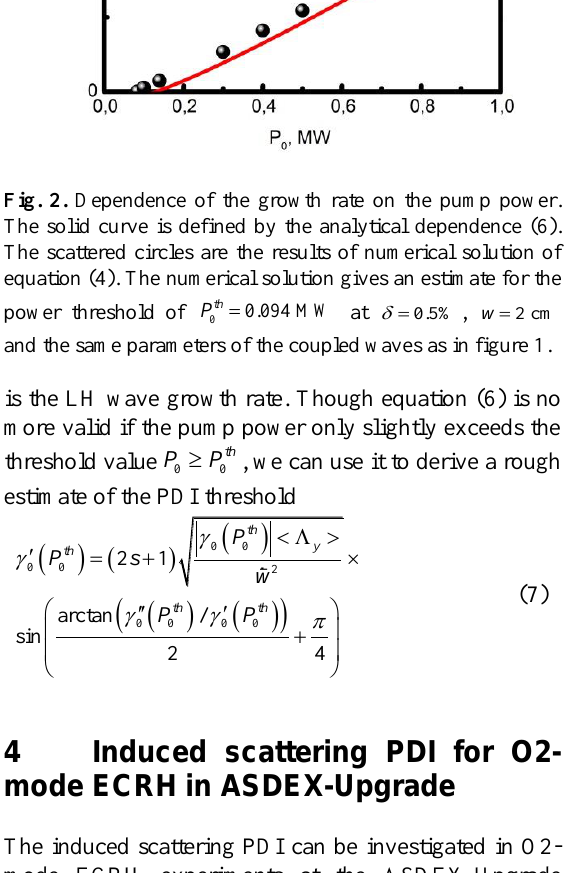
the pump power. The solid curve is given by (6).